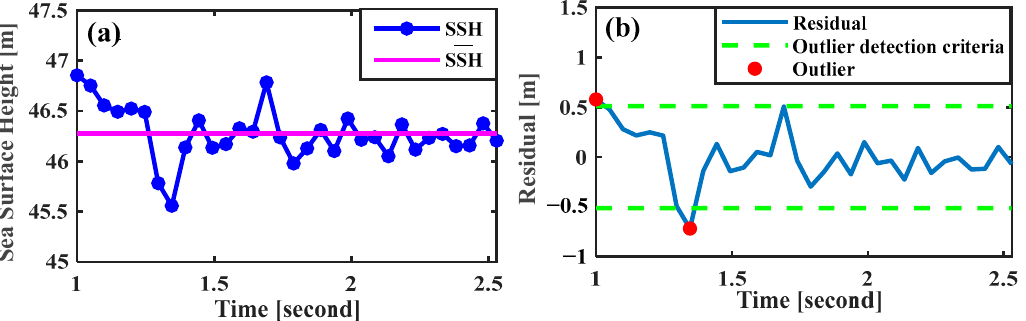
Figure 13. ( a ) The instantaneous (blue) and mean (magenta) water level of the Bay of Biscay from track 485 and cycle 39 as well as ( b ) outliers’ rejection.